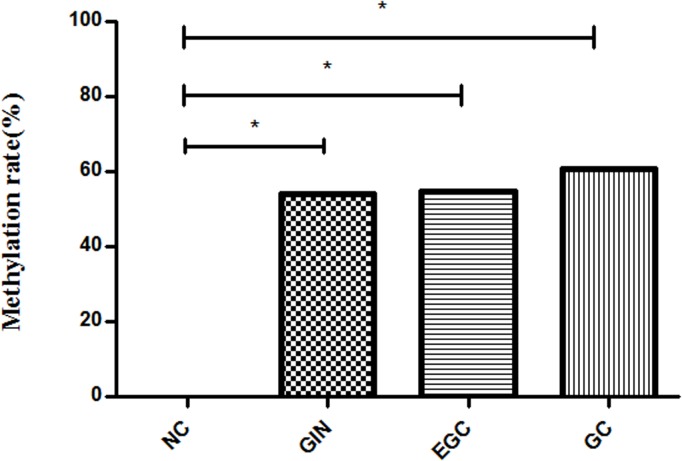
Percentage of Zic1 promoter methylation in the gastric cancer (GC), gastric intraepithelial neoplasia (GIN), early gastric cancer (ECG) and normal control (NC) groups.The percentages of Zic1 promoter methylation were 60.6% (63/104) in the GC, 54.0% (27/50) in the GIN, 54.8% (17/31) in the EGC and 0.0% (0/20) in the NC groups (*: p < 0.001).